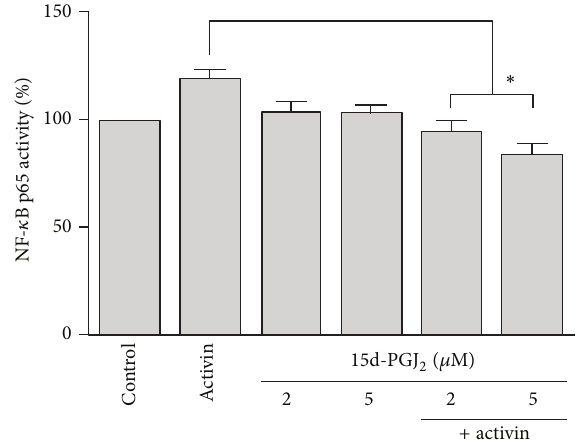
Figure 4: NF- 𝜅 B p65 activity in HepG2 cells. Cells were stimulated with activin A (25 ng/mL) and 15d-PGJ 2 (2 or 5 𝜇 M) for 72 h. NF- 𝜅 B p65 activity in the culture nuclear extracts was determined using ELISA. The data represent the mean ± SEM of 3 independent samples. ∗ 𝑃 < 0.05 , comparison of stimulation with 15d-PGJ 2 and activin A versus activin A stimulation